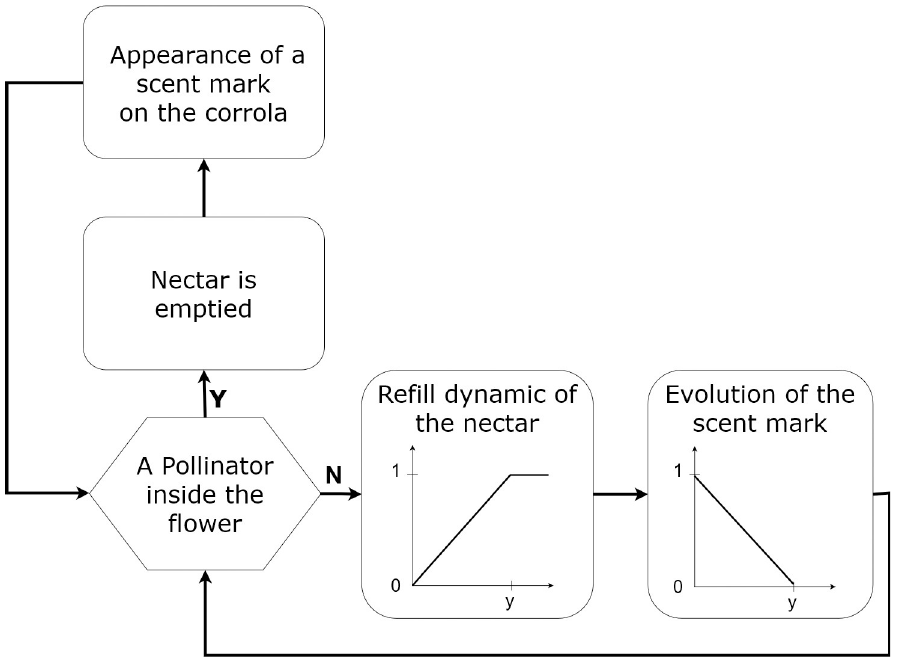
Fig 2. Scheduling of the